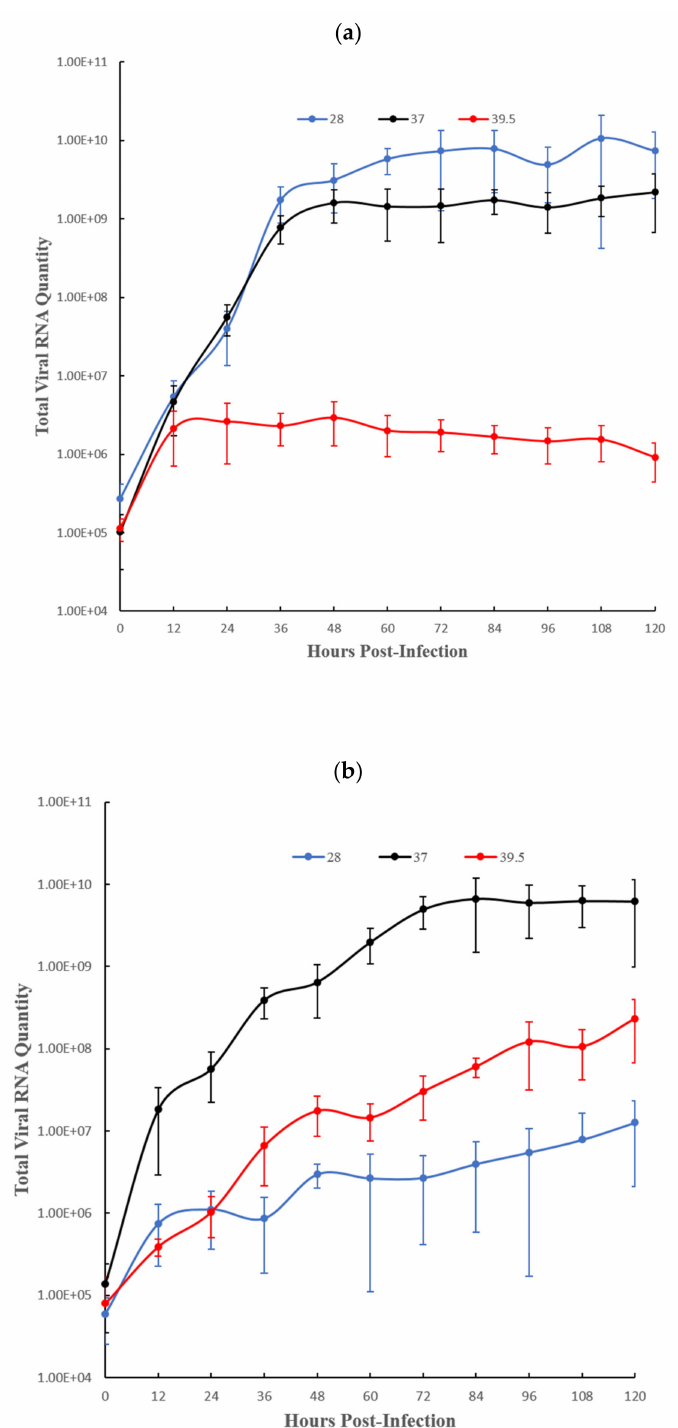
Figure 1. Virus growth kinetics of ( a ) EV71:TLL β P20 and ( b ) its parental wild-type ST strain by total viral RNA quantity in the culture supernatant of infected Vero cells incubated at 28 ◦ C (blue line), 37 ◦ C (black line) and 39.5 ◦ C (red